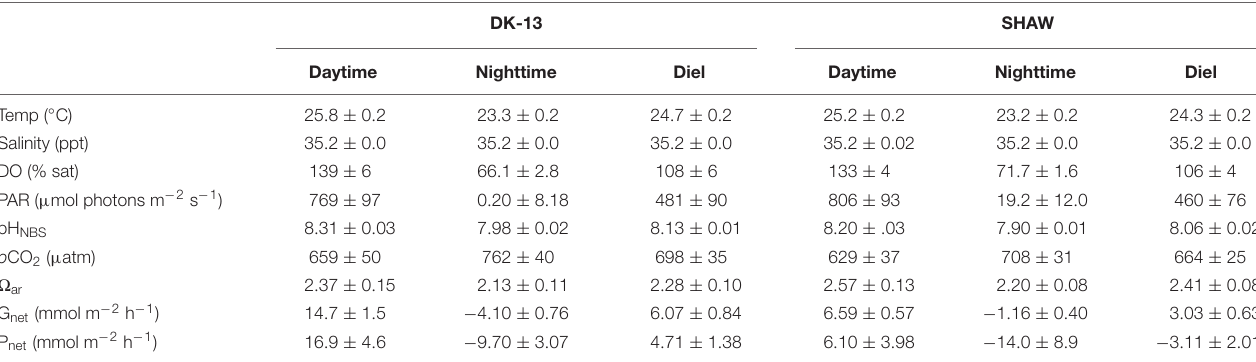
TABLE 1 | Daytime (0600–1900), nighttime (1900–0600), and diel averages ( ± SE) of seawater chemistry observations and metabolic estimates at each site during low tide slack periods from 14 to 26 November